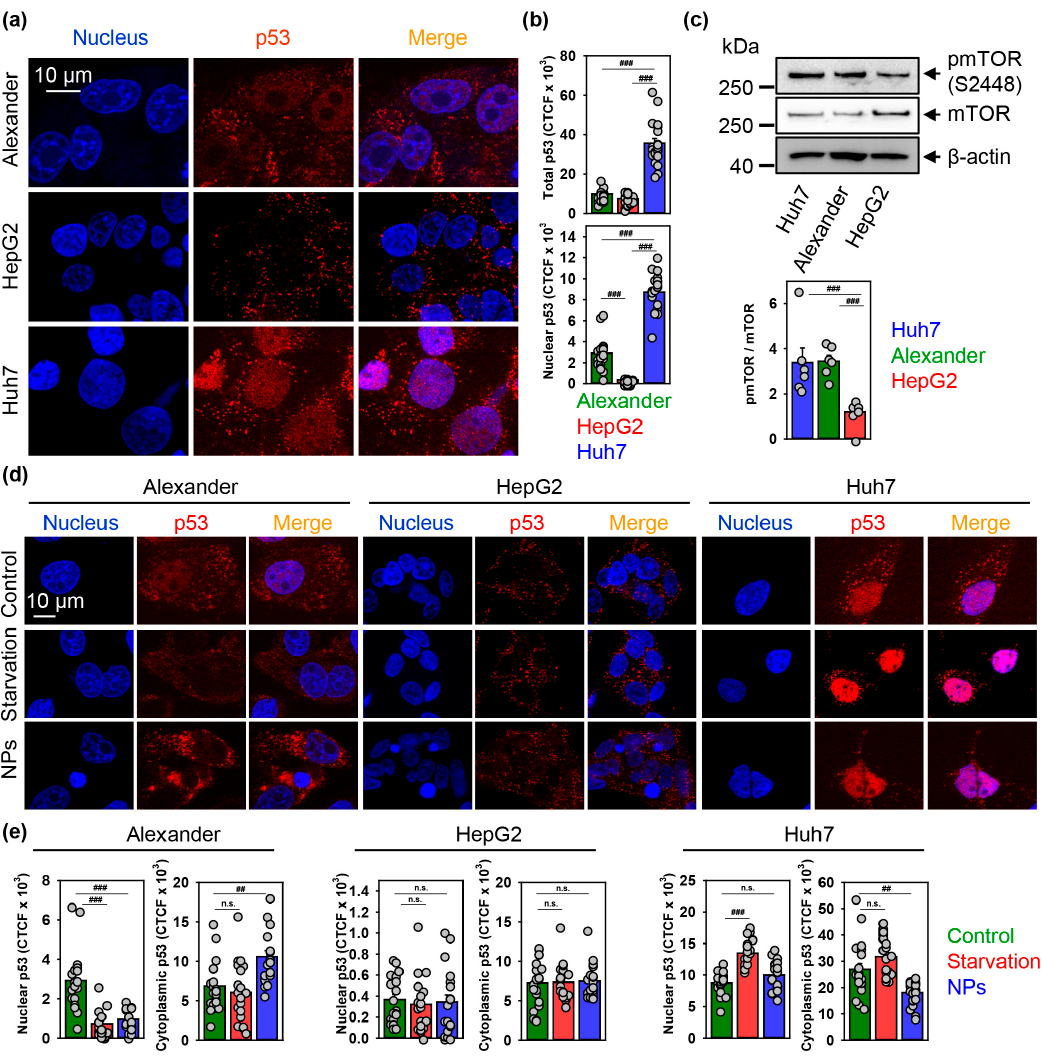
Figure 8. Nanoparticles a ff ect p53 nuclear shuttling. ( a , b ) Representative confocal microscopic images and quantification of p53 sub-cellular localization in distinct cell lines. Huh7, HepG2 and Alexander cells were fixed and immunostained for p53 (red). Nuclei were stained with Hoechst 33342. Labeled cells were then imaged using spinning disk confocal microscopy ( a ). Quantification of p53 cellular fluorescence ( b ) was done by ImageJ and presented as means of n = 20 cells. (###) p < 0.001 denotes significant di ff erences. ( c ) Expressions of pmTOR and mTOR were analyzed in whole cell lysates of HepG2, Huh7, Alexander cells by immunoblotting. Actin—control of equal protein loading. The graphs show densitometric quantification of pmTOR / mTOR ratio. Quantification performed using ImageJ. The data are expressed as mean ± SEM, n = 5–6. (###) p < 0.001 denotes significant di ff erences. ( d , e ) Representative confocal microscopic images and quantification of p53 sub-cellular localization in distinct cell lines upon nanoparticle treatment. Cells were treated for 12 h with nanoparticles 50 µ g Fe mL − 1 , fixed and immunostained for p53 (red). Labeled cells were then imaged using spinning disk confocal microscopy ( d ). Positive control—serum starvation for 12 h. Nuclei were stained with Hoechst 33342. Quantification of p53 cellular fluorescence ( e ) was done by ImageJ and presented as means of n = 20 cells. (##) p < 0.01 and (###) p < 0.001 denote significant differences. Of note, both Huh7 and Alexander cell express mutated p53, and in contrast, HepG2 cells have wild type form of p53 [92,93]. In addition, mutated p53 has been shown to enhance the mTOR activity